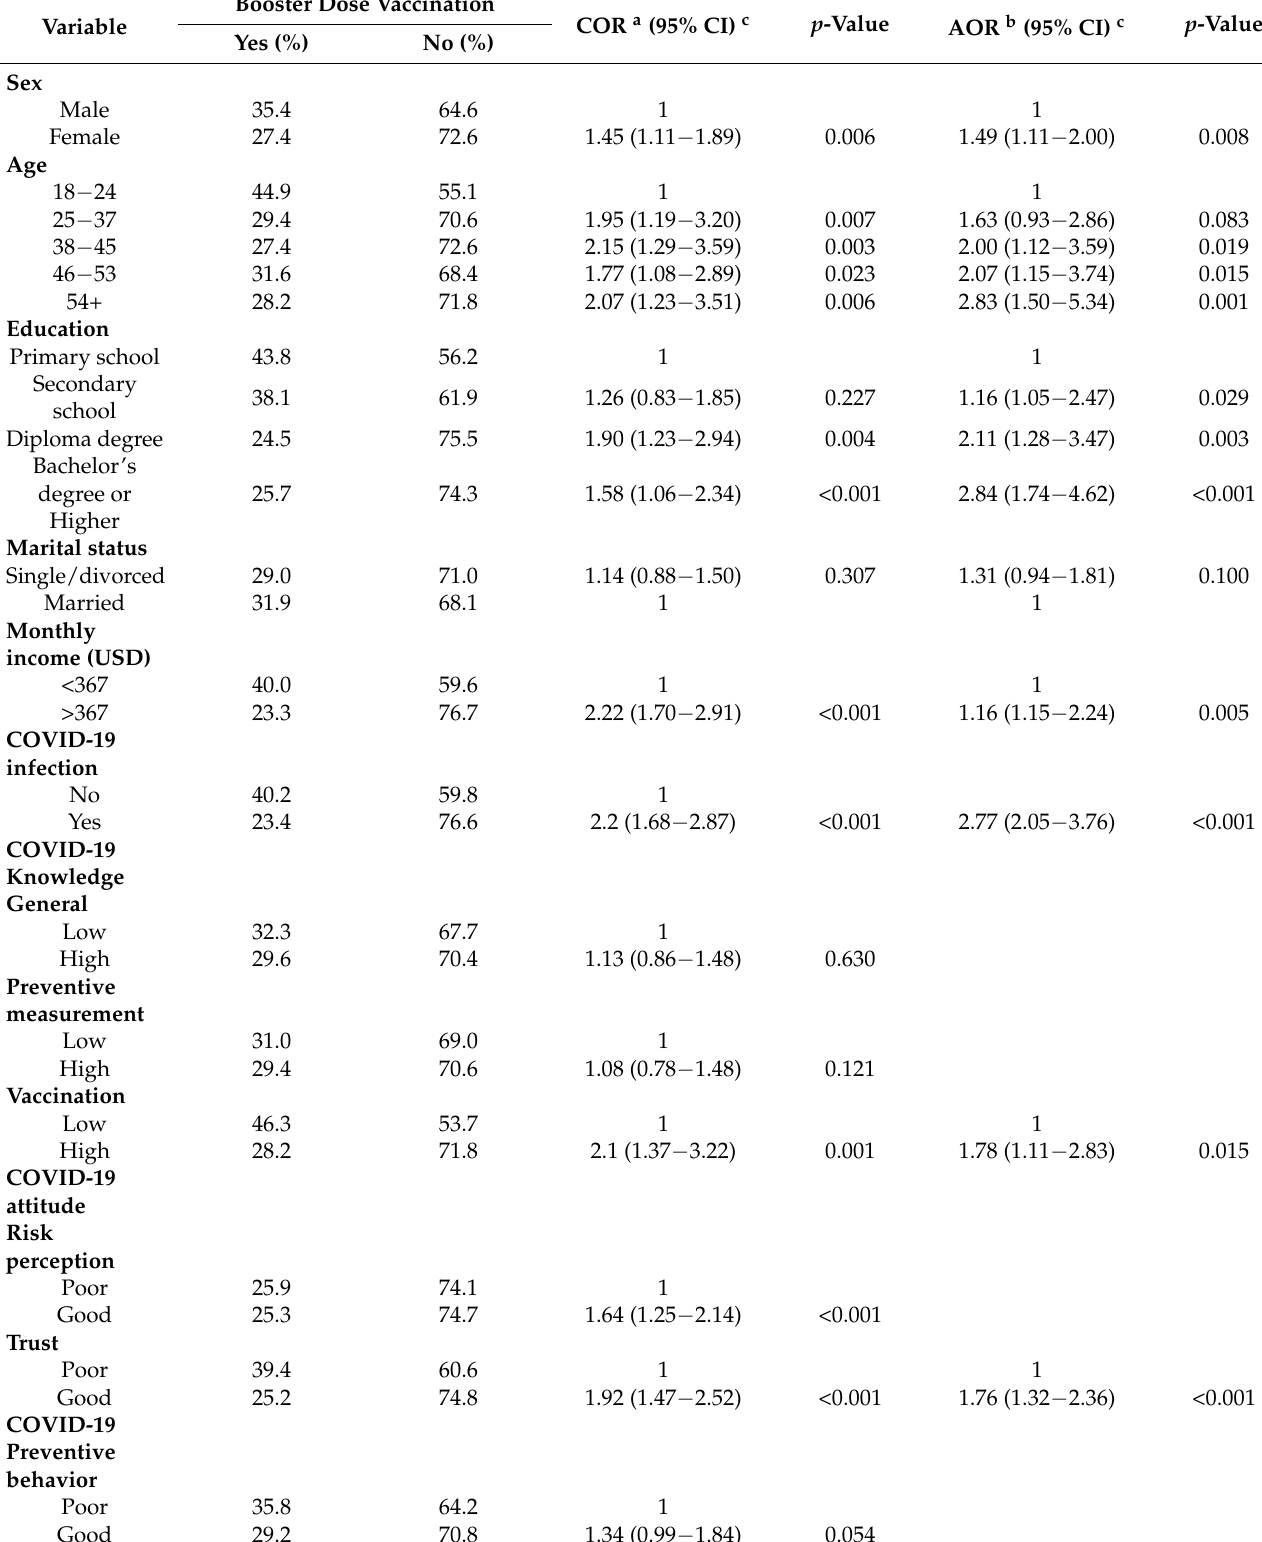
Table 6. Logistic regressions model for COVID-19 booster dose